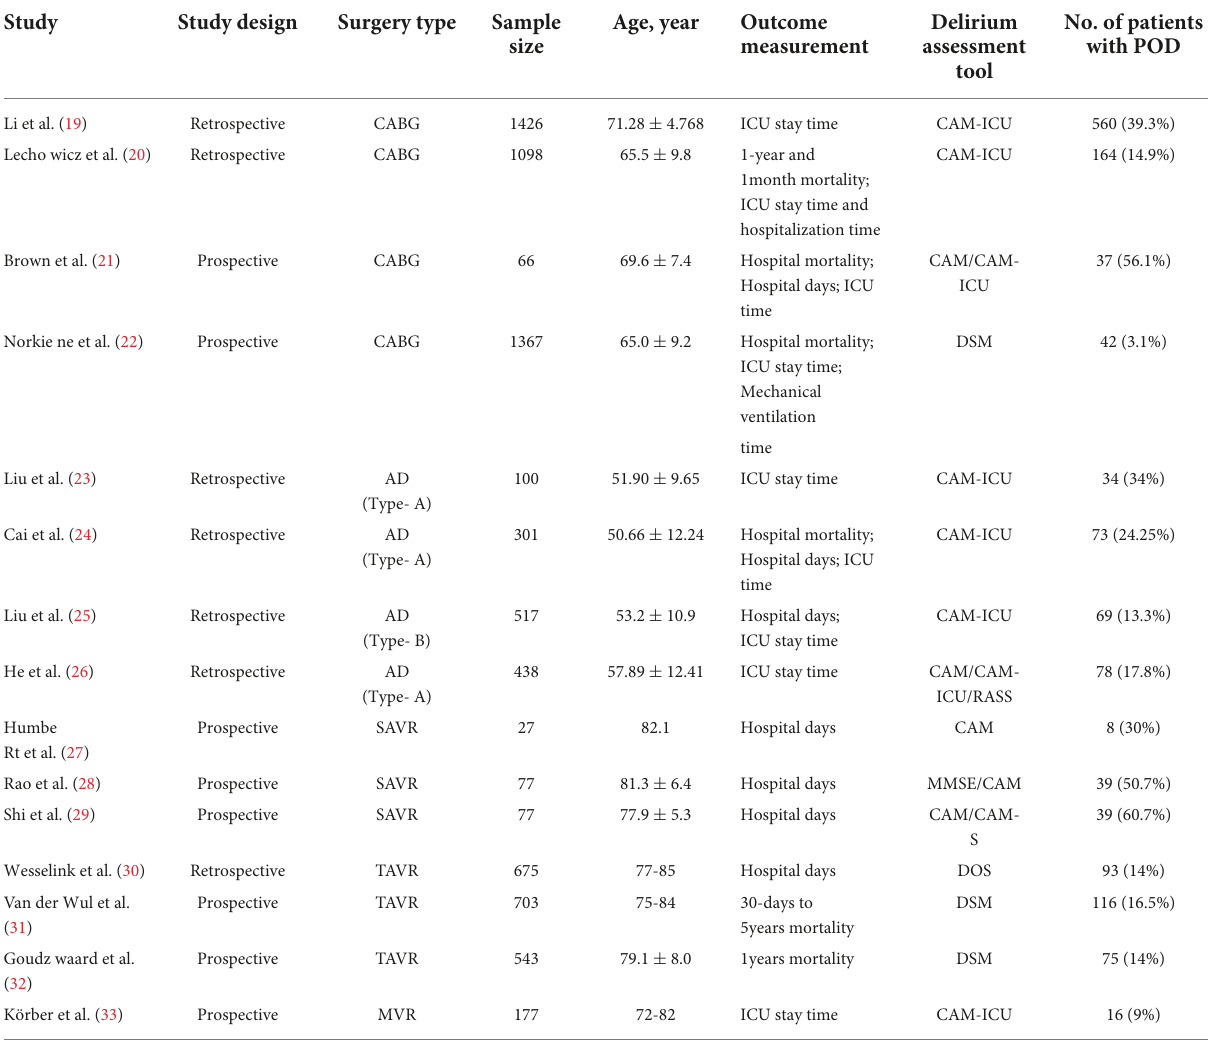
TABLE 1 A comparison of the incidence of delirium after different cardiac